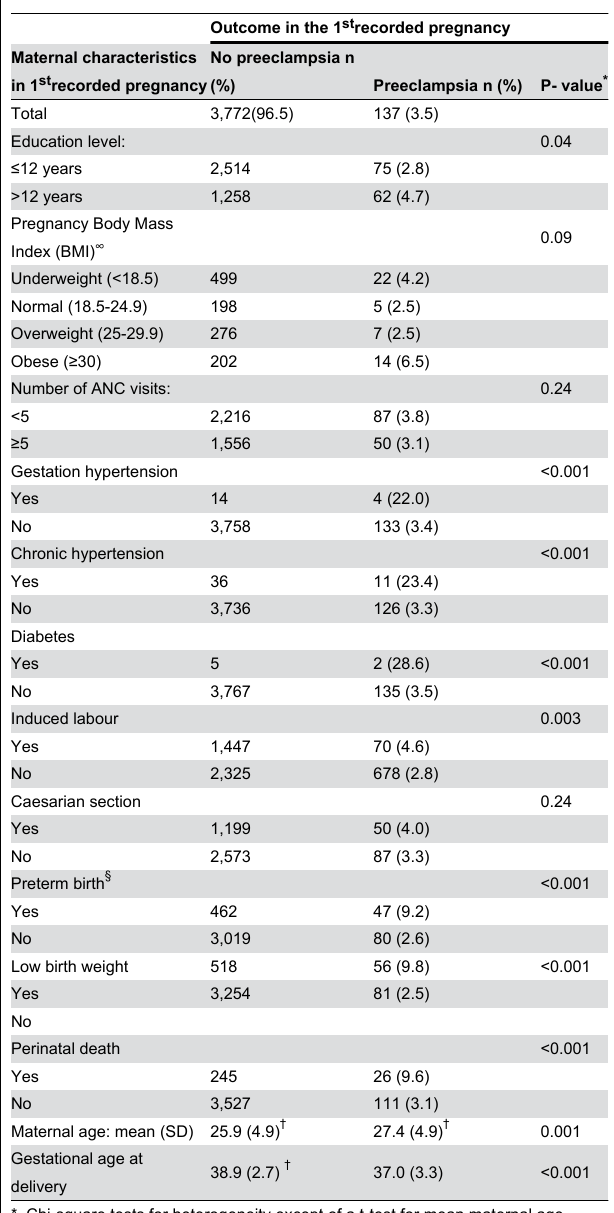
Outcome in the 1 st recorded pregnancy